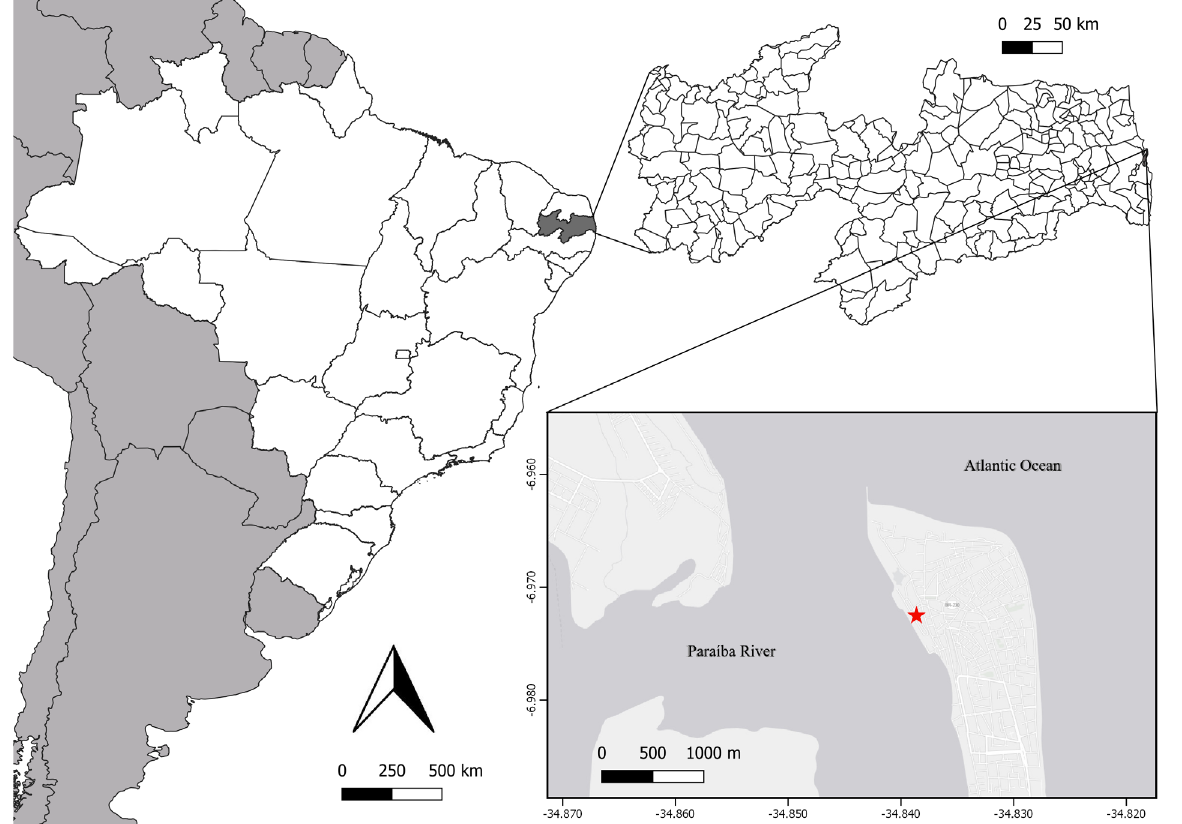
Figure 1. Sampling area, near the Port of Cabedelo (star), state of Paraíba,